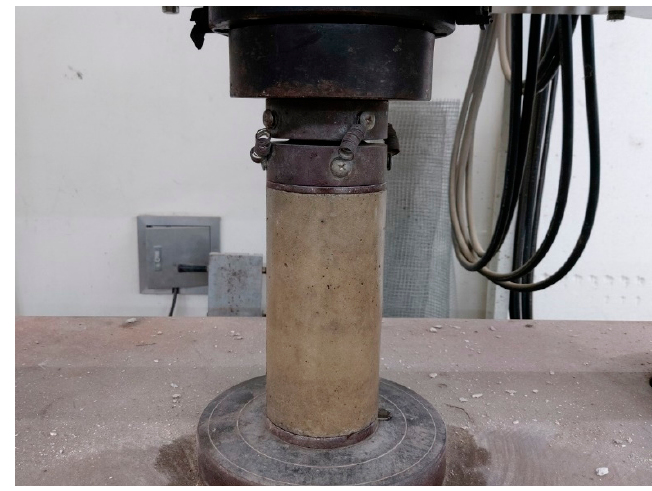
Figure 2. Compressive strength test configuration.